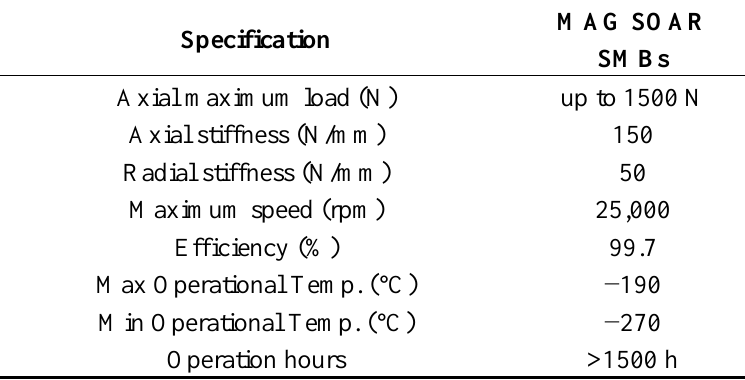
Table 4. Superconducting magnetic bearing